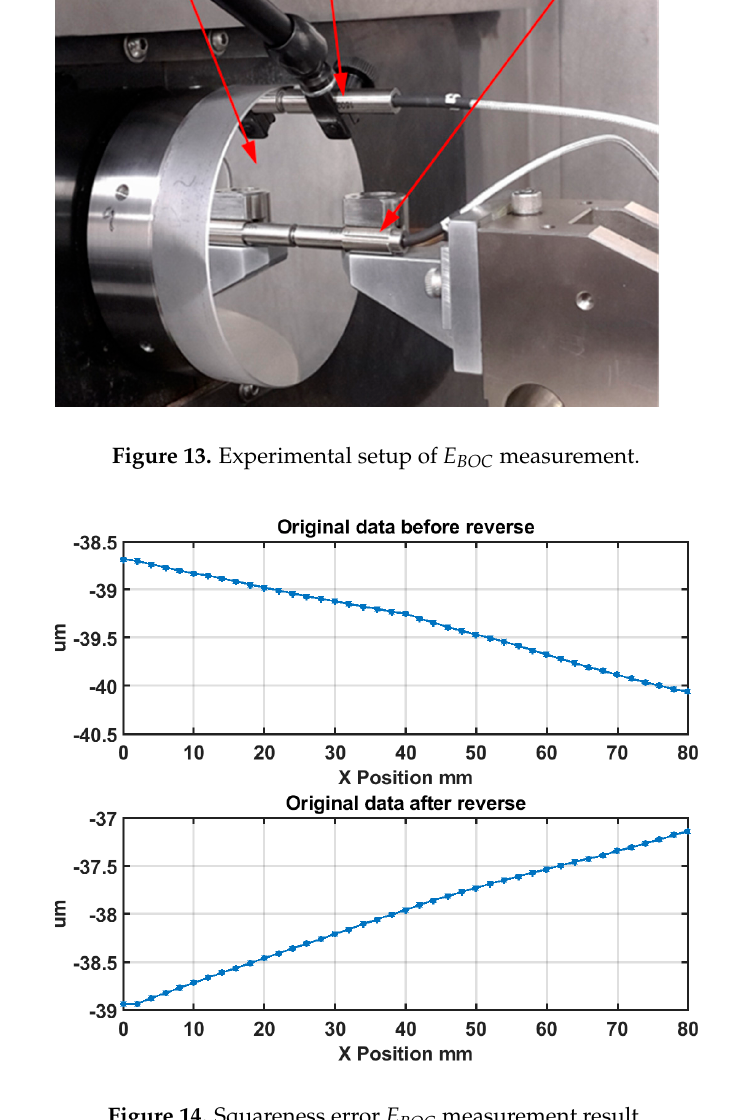
Figure 14. Squareness error E BOC measurement result.